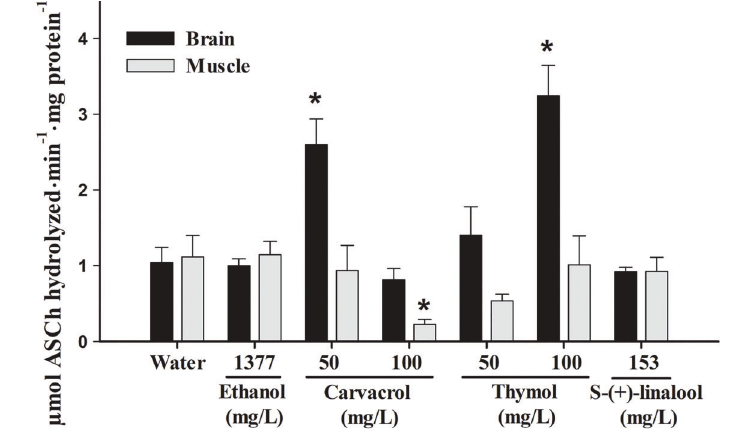
Figure 2. Acetylcholinesterase (AChE) activity in the brain and muscle of silver cat fi sh ( Rhamdia quelen ) juveniles anesthetized with thymol and carvacrol (50 and 100 mg/L) and S-( + )-linalool (153 mg/L). Data are reported as means ± SD (n=6). ASCh: acetylthiocholine. *P o 0.05, com- pared to the control (water) group in the same tissue (one-way ANOVA and Tukey ’ s test or Kruskal-Wallis ANOVA by